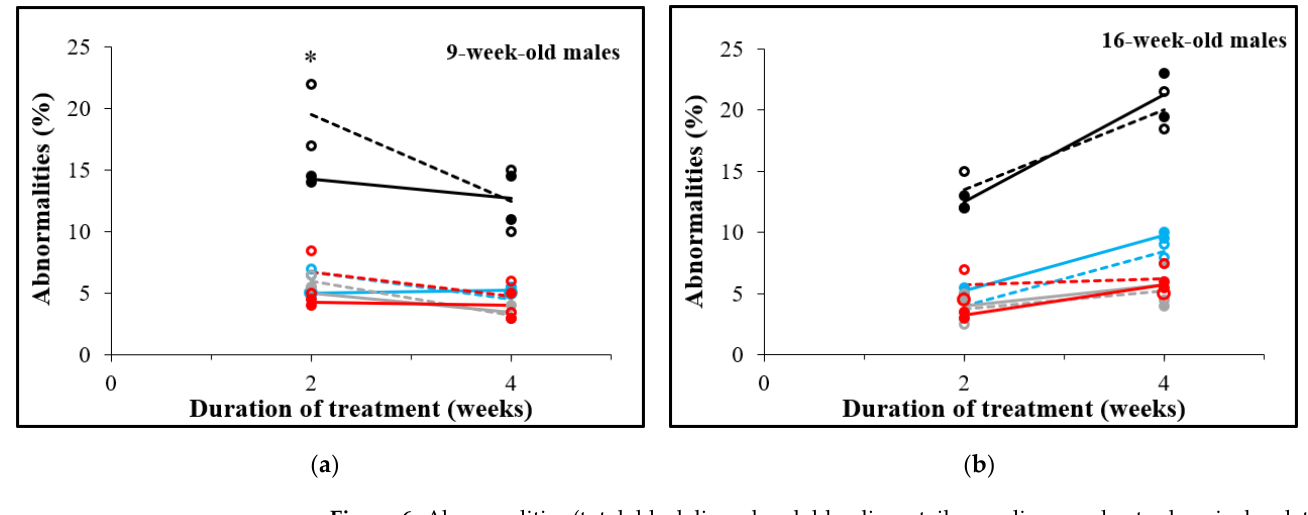
Figure 6. Abnormalities (total: black lines; head: blue lines; tail: gray lines; and cytoplasmic droplet: red lines) of spermatozoa from males treated (continuous lines, single values are shown in solid circles) or not treated (dotted lines, single values are shown in open circles) with D-Asp. Males were either 9 weeks old ( a ) or 16 weeks old ( b ). The results are shown as a mean of two replicates of 200 spermatozoa each. Significant differences between D-Asp-treated males and controls are marked as follows: *: p < 0.05.